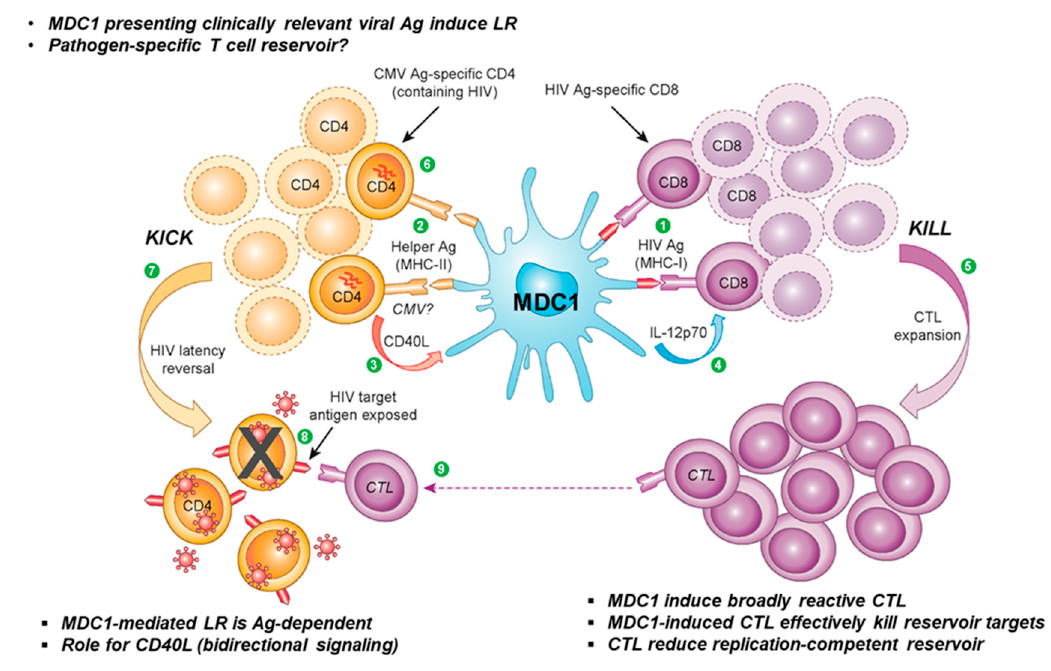
Figure 1. Monocyte-derived DC (MDC1): the all-in-one ‘kick and kill’ tool. MDC1s induce antigen-specific CD8 + and CD4 + T cell responses through presentation of antigenic peptides in the context of (1) MHC class-I and (2) MHC class-II molecules, respectively (signal 1), along with costimulatory factors including CD80 and CD86 (not shown, signal 2). Responding CD4 + T cells subsequently provide MDC1 with the feedback hyperactivating ‘helper’ signal CD40L (3) , necessary for MDC1 release of IL-12p70 (4) , which then promotes expansion and differentiation of CD8 + human immunodeficiency virus-1 (HIV-1)-specific effector cytotoxic T lymphocytes (CTLs) (5) . Activation of CMV and HIV antigen-responsive CD4 + T cells harboring latent HIV-1 (6) results in HIV latency reversal (7) , with HIV-1 proteins being transcribed and expressed as surface antigen (8) . As a result, exposed infected cells harboring replication-competent provirus are targeted for elimination by HIV-specific CTLs (9) .